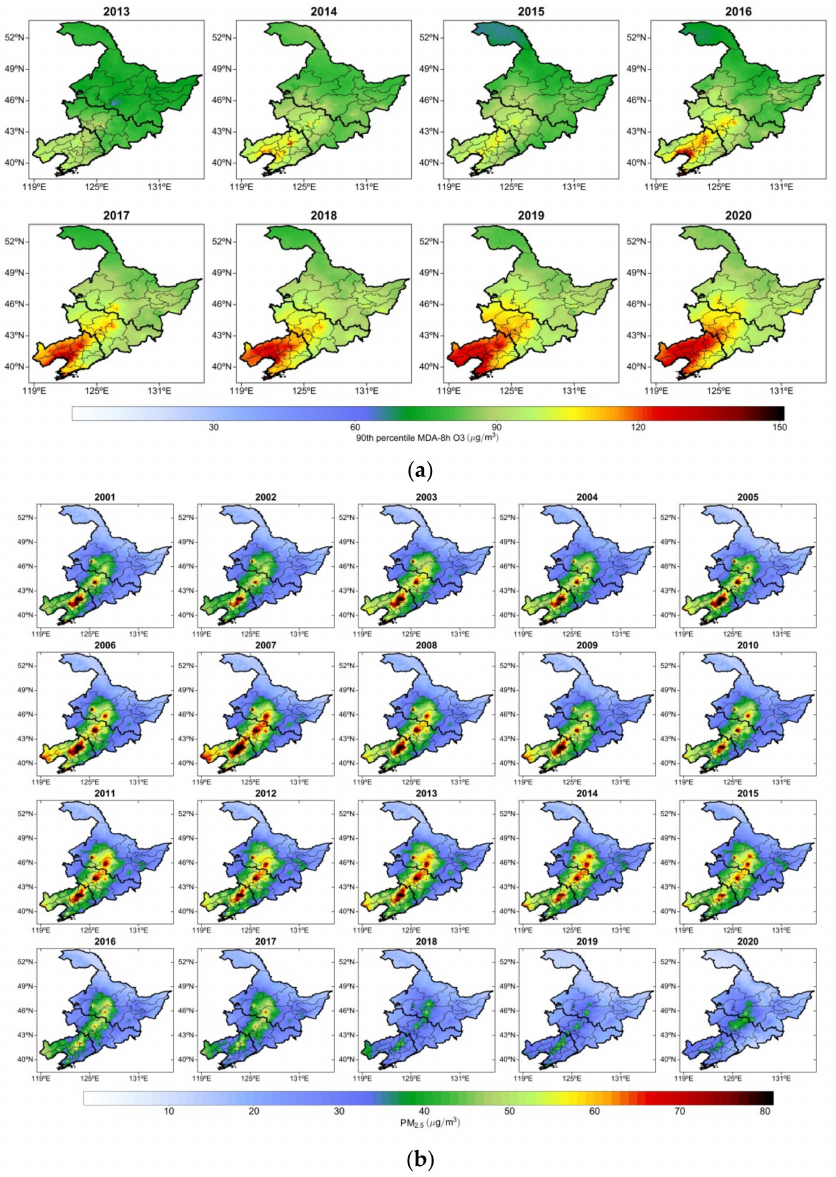
Figure 5. Spatial distribution of mean annual concentrations of ( a ) O 3 -8h-90per from 2013–2020 and ( b ) PM 2.5 from 2001–2020 in